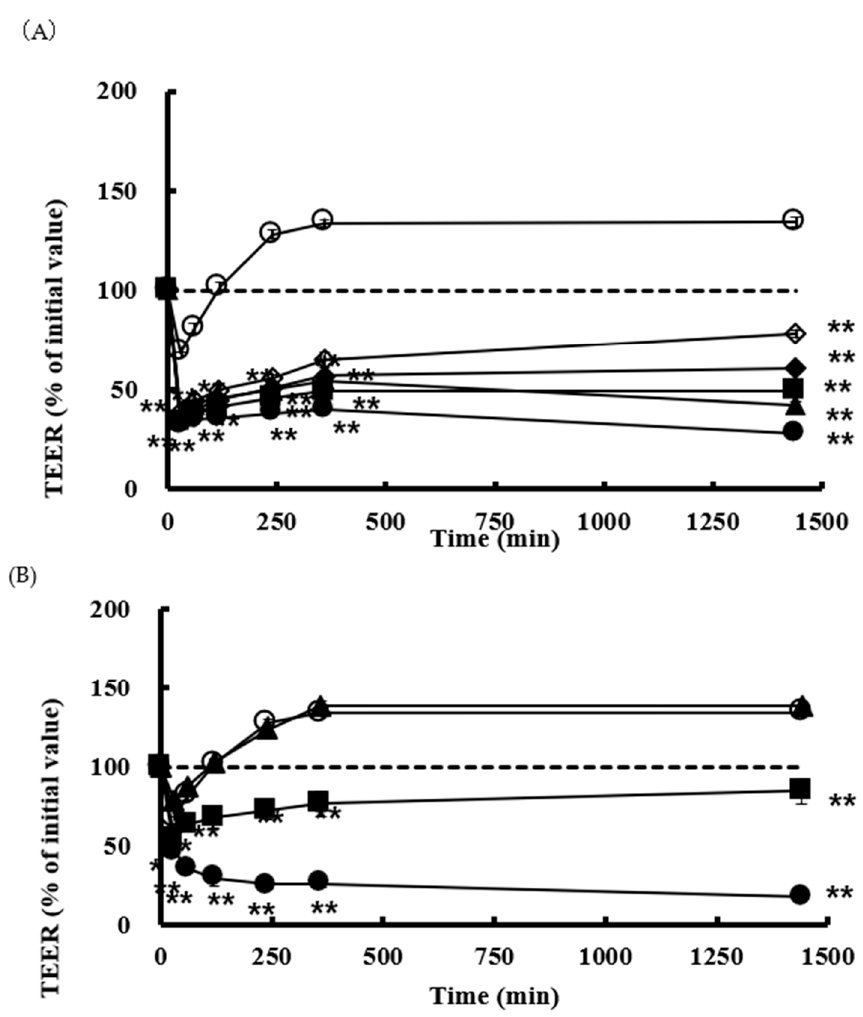
Figure 6. ( A ) The evaluation of the membrane toxicity of Caco-2 cells monolayers in the existence of SLG-30, sodium glycocholate, and sodium laurate and ( B ) the relationship between the effects of SLG- 30 and typical absorption enhancers on the CF permeability across Caco-2 cells and their toxic effects: The results are expressed as the mean ± S.E. ( n = 6). ** p < 0.01, n.s. not significantly different when compared with the control. Keys for Figure 6B: ( ◯ ) Control, ( ∆ ) 0.001% ( v / v ) SLG-30, ( ) 0.01% ( v / v ) SLG-30, ( ■ ) 0.025% ( v / v ) SLG-30, ( ▲ ) 0.05% ( v / v ) SLG-30, ( ● ) 0.1% ( v / v ) SLG-30. ( ) 0.1% ( w / v ) sodium glycocholate, ( □ ) 1% ( w / v ) sodium glycocholate, and ( ◆ ) 0.05% ( w / v ) sodium laurate.